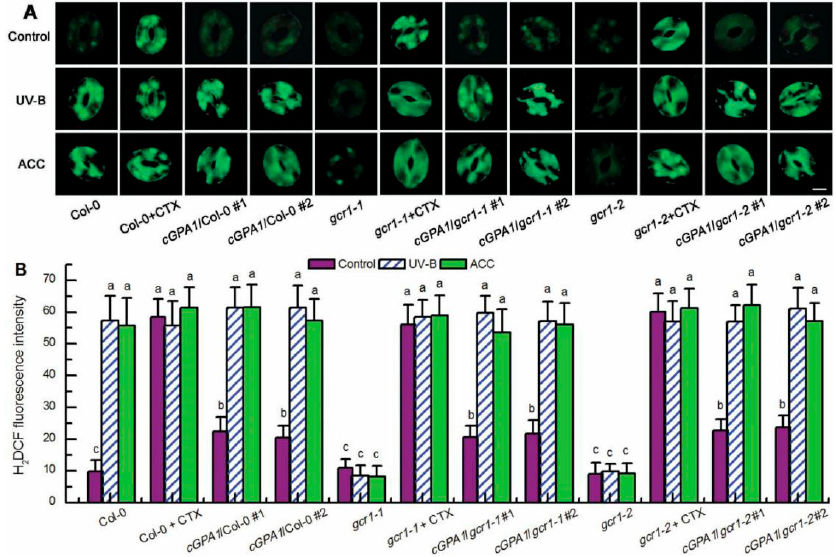
Figure 3. GCR1 mediates UV-B- and ethylene-induced ROS production in guard cells via activating G α subunit GPA1. Leaves of the wild-type Col-0, gcr1 mutants, and transgenic plants cGPA1 /Col- 0/ gcr1-1 / gcr1-2 were floated on MES buffer in the absence or presence of 400 ng/mL CTX or 100 μ mol/L ACC (ACC) and exposed to light alone (Control) or with 0.5 W/m 2 UV-B (UV-B) for 3 h. Then the images ( A ) and fluorescence intensities ( B ) of guard cells preloaded with H 2 DCFDA were recorded. For ( A ), scale bar = 10 μ m. For ( B ), data are shown as means ± SE ( n = 3), each with 20 stomata. Means with different letters are significantly different at p < 0.05.